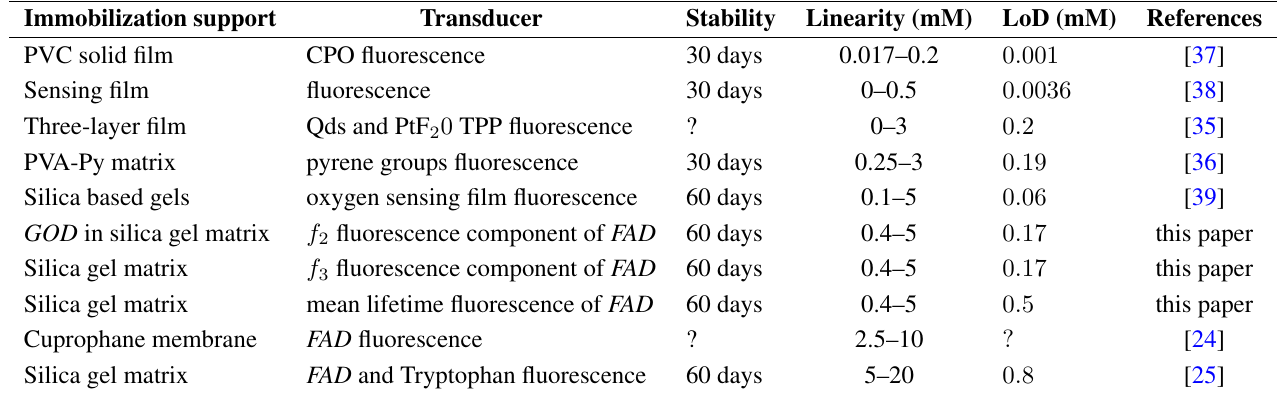
Table 3. Analytical performance of various GOD -based optical biosensors. Immobilization